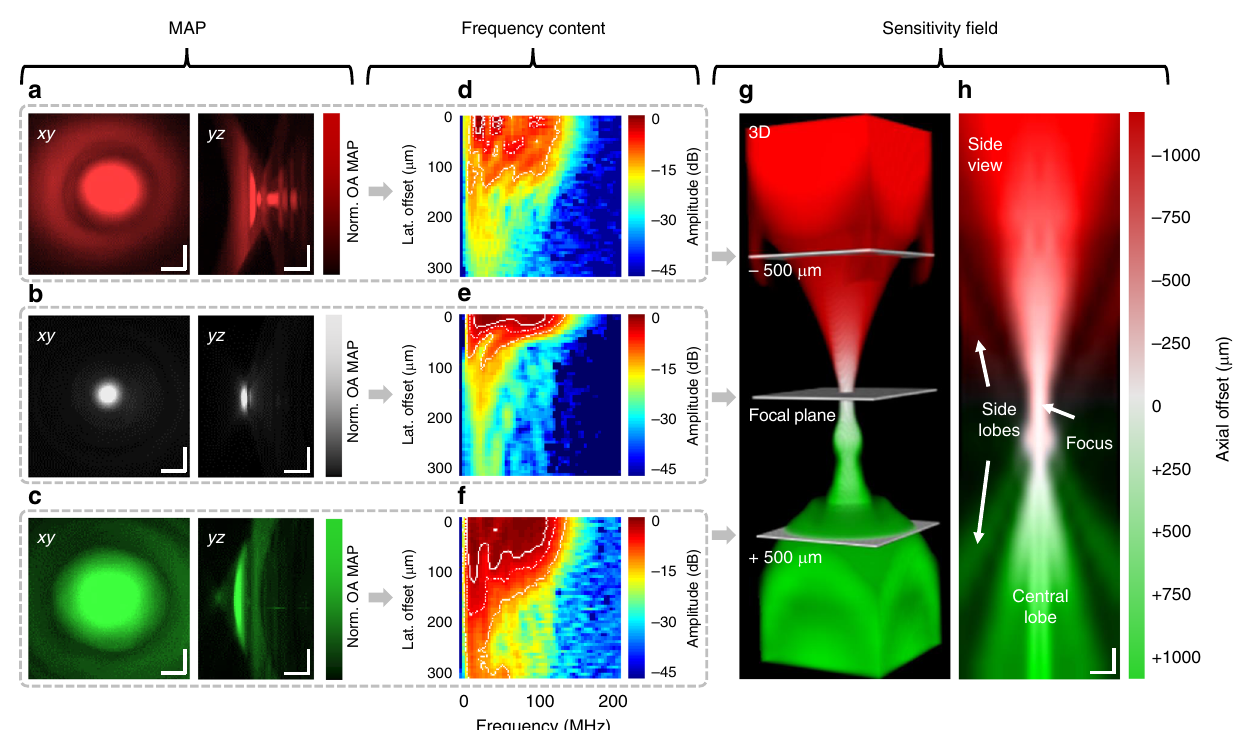
Fig. 3 Experimental determination of the TIR of a spherically focused 50-MHz transducer. The TIR was determined by raster scanning the optical excitation across a GL. Raw OR-optoacoustic microscopy MAP onto the xy - (left panel) and yz -plane (right panel) when the transducer was a 500 µ m negatively defocused (red), b in-focus (white), and c 500 µ m positively defocused (green). d – f Frequency contents for the three cases. Dashed lines show boundaries of − 3, − 6, and − 12 dB. g Joined 3D sensitivity fi eld of the transducer. h Side view of the central plane of the 3D sensitivity fi eld. Scale